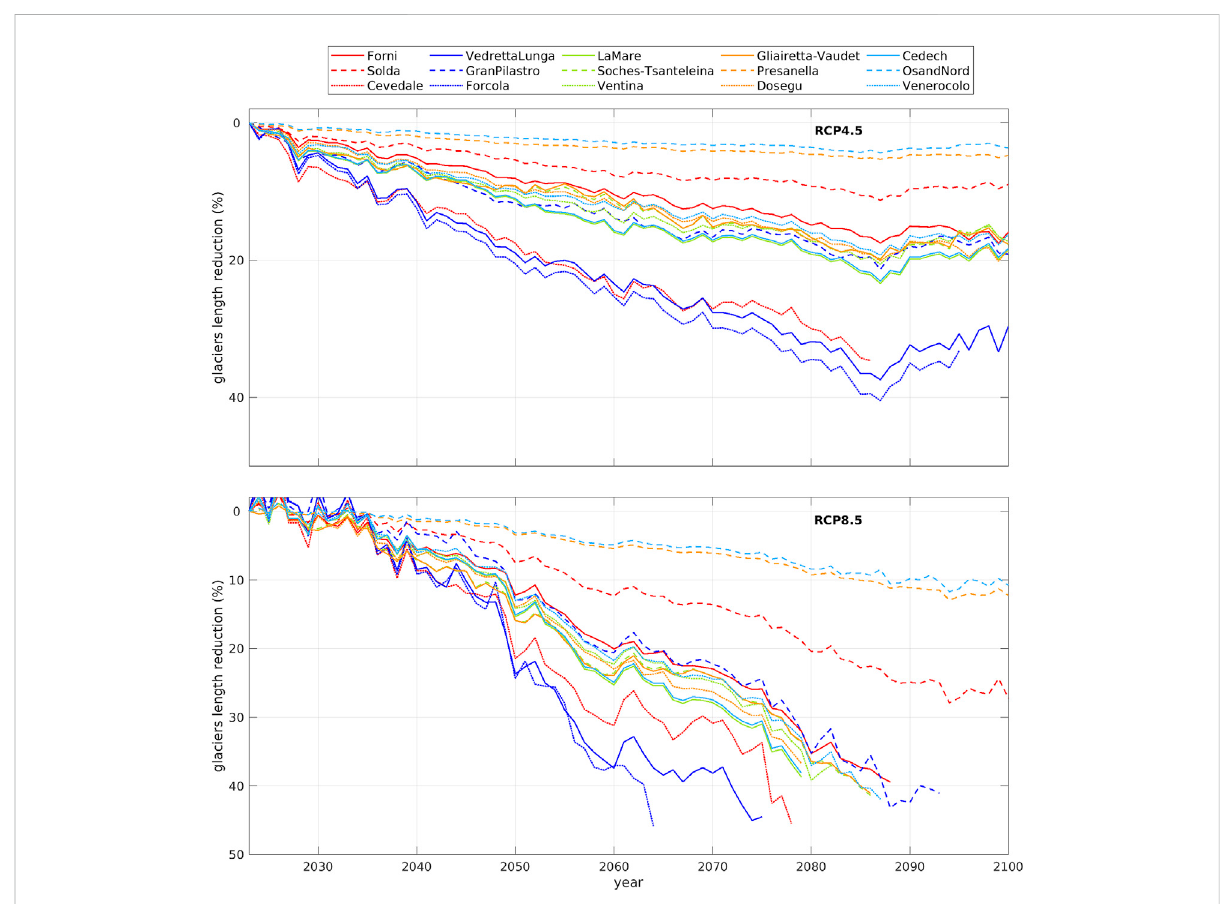
FIGURE 7 The percent glaciers length variations derived from climatological projections from 2023 to 2100. Top panel: RCP4.5 scenario. Bottom panel: RCP8.5 scenario. The colours are sorted from the longest (red) to the shortest (light blue)